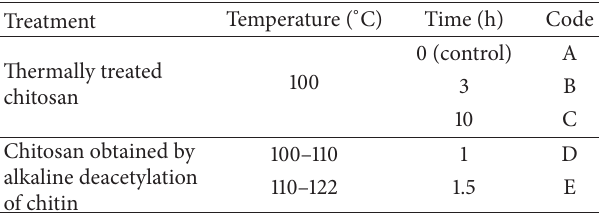
Table 1: Chitosan samples used to determine the viscosity average molar masses (Mv).